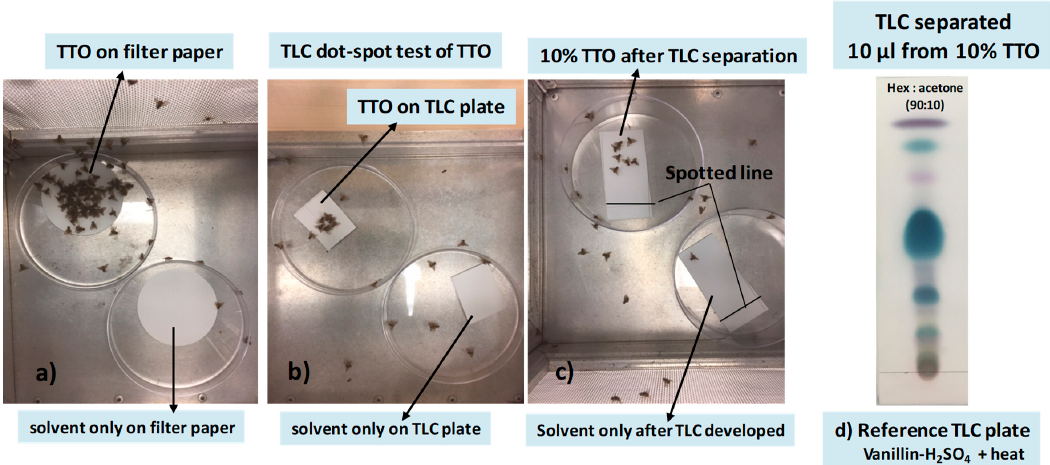
Figure 2. Comparison of the responses of male medflies (100 per cage). Pictures were taken after 10 min. Photo credit: Micah Gill (USDA-ARS, SHRS) ( a ) Filter paper test: 10 µ L of 10% tea tree oil